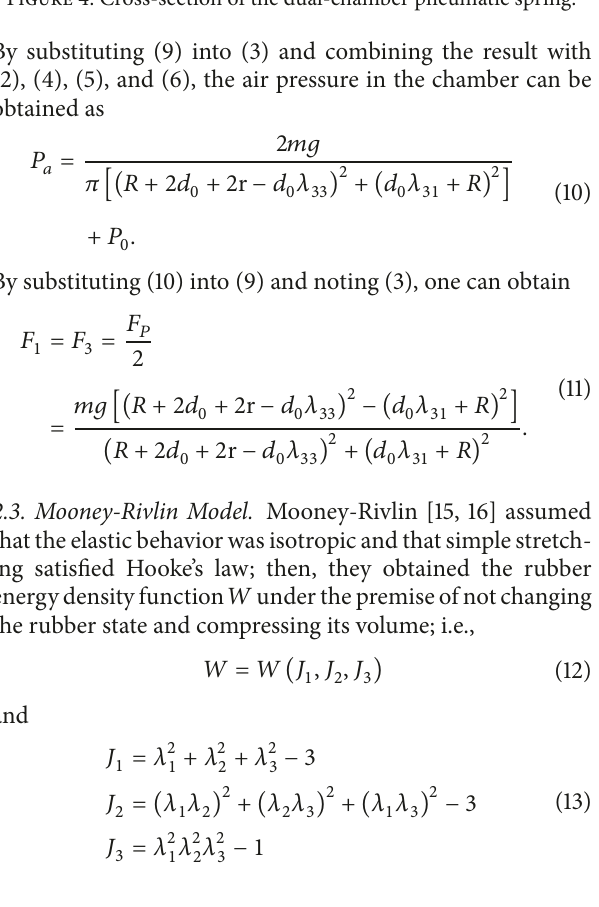
Figure 4: Cross-section of the dual-chamber pneumatic